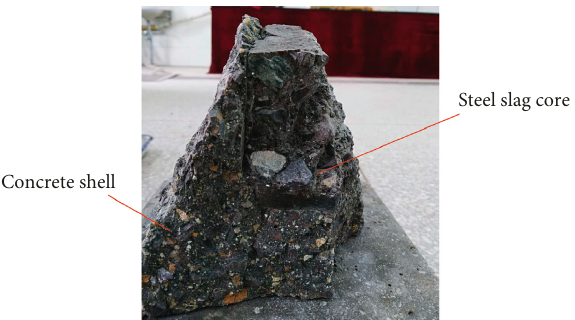
Figure 5: Failure morphology of the specimen after compression